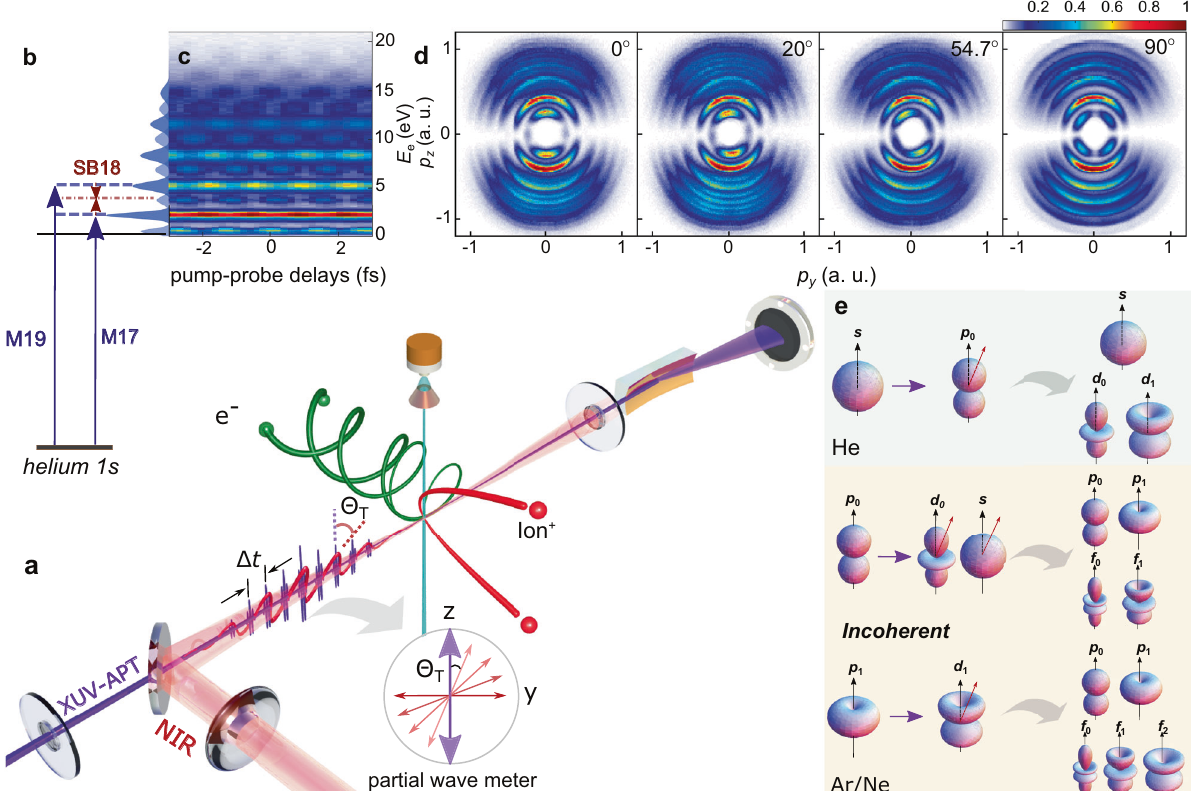
Fig.1|Schematicdiagramofattosecondcoincidencemetrology.a Experimental setup. The polarization-skewed XUV-APT and NIR laser fi eld were focused onto a supersonic gas jet via an actively stabilized interferometer. The three-dimensional momentaofthe photoionizedionsandelectronsweremeasured in coincidenceas a function of the XUV-APT/NIR pump-probe delay, and the XUV spectrum is char- acterized via an online soft-X-ray spectrometer. b The principle of sideband